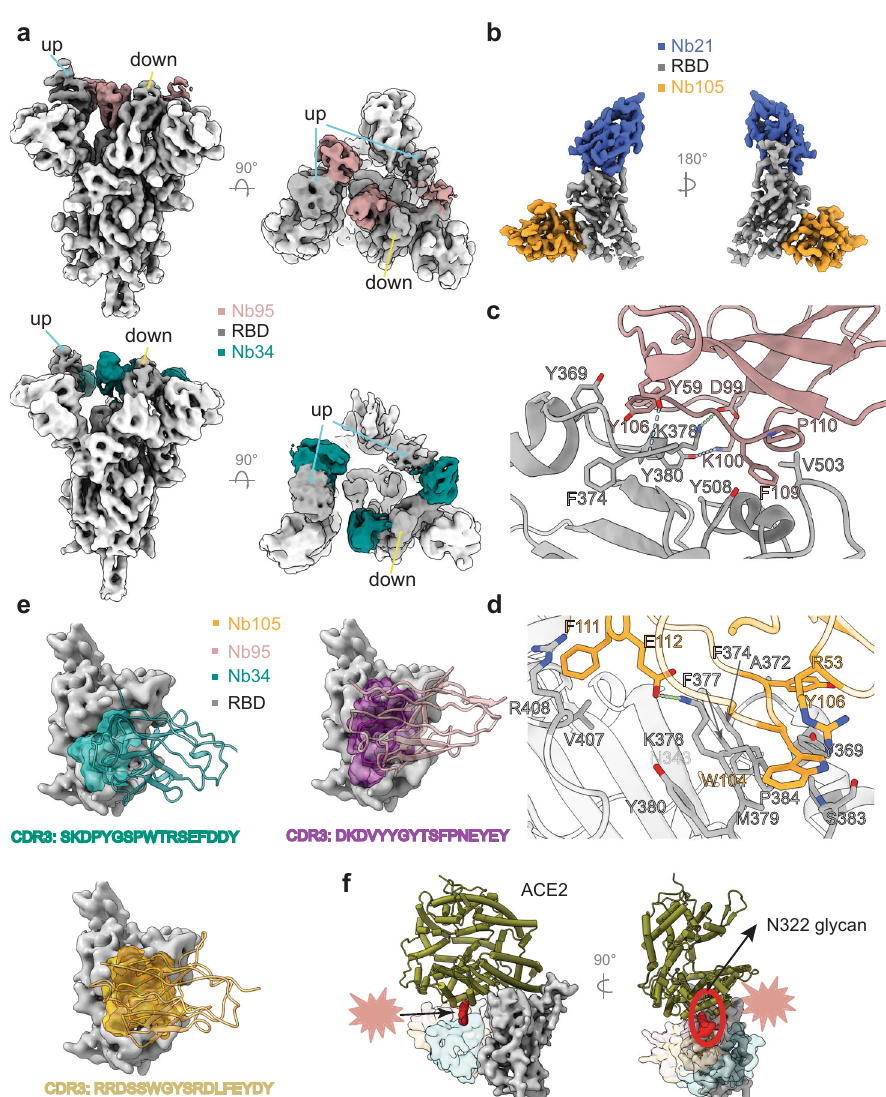
Fig. 3 Structures of class II Nbs (95, 34, and 105). a Cryo-EM structures of Nbs 95 and 34 in complex with S. b Cryo-EM structure of the Nb105:Nb21: RBD complex. c Nb95: RBD interactions. Residues in pink denote Nb95 for RBD binding. d Nb105: RBD interactions. Residues in yellow denote Nb105 for RBD binding. e Class II Nb:RBD interactions are predominantly mediated by CDR3. Nbs are represented as ribbons. The CDR3 loops are shown as